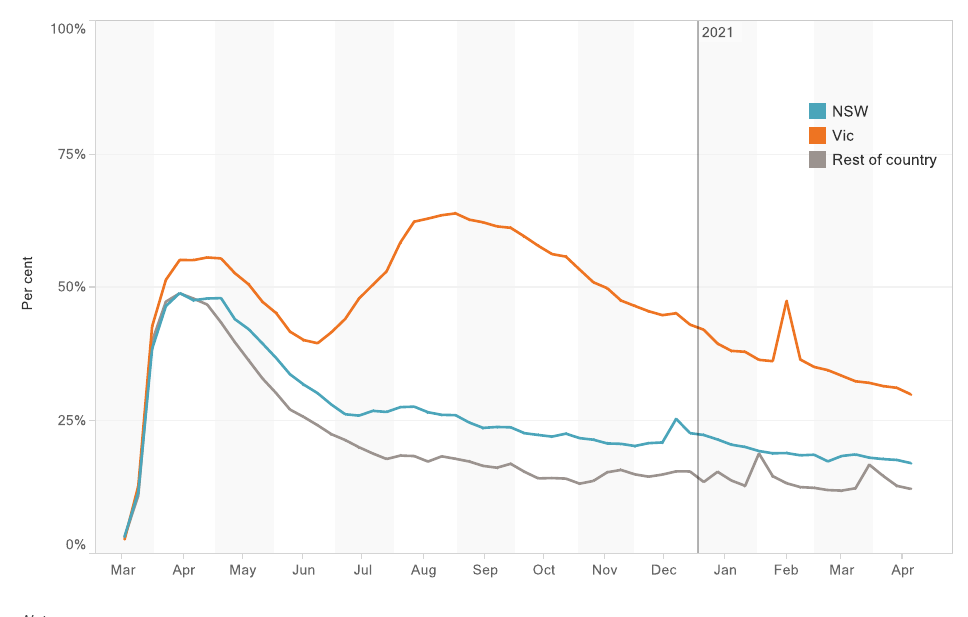
Figure 4. MBS mental health telehealth services (proportion of all MBS mental health services), by jurisdiction, March 2020–April 2021. (Website: